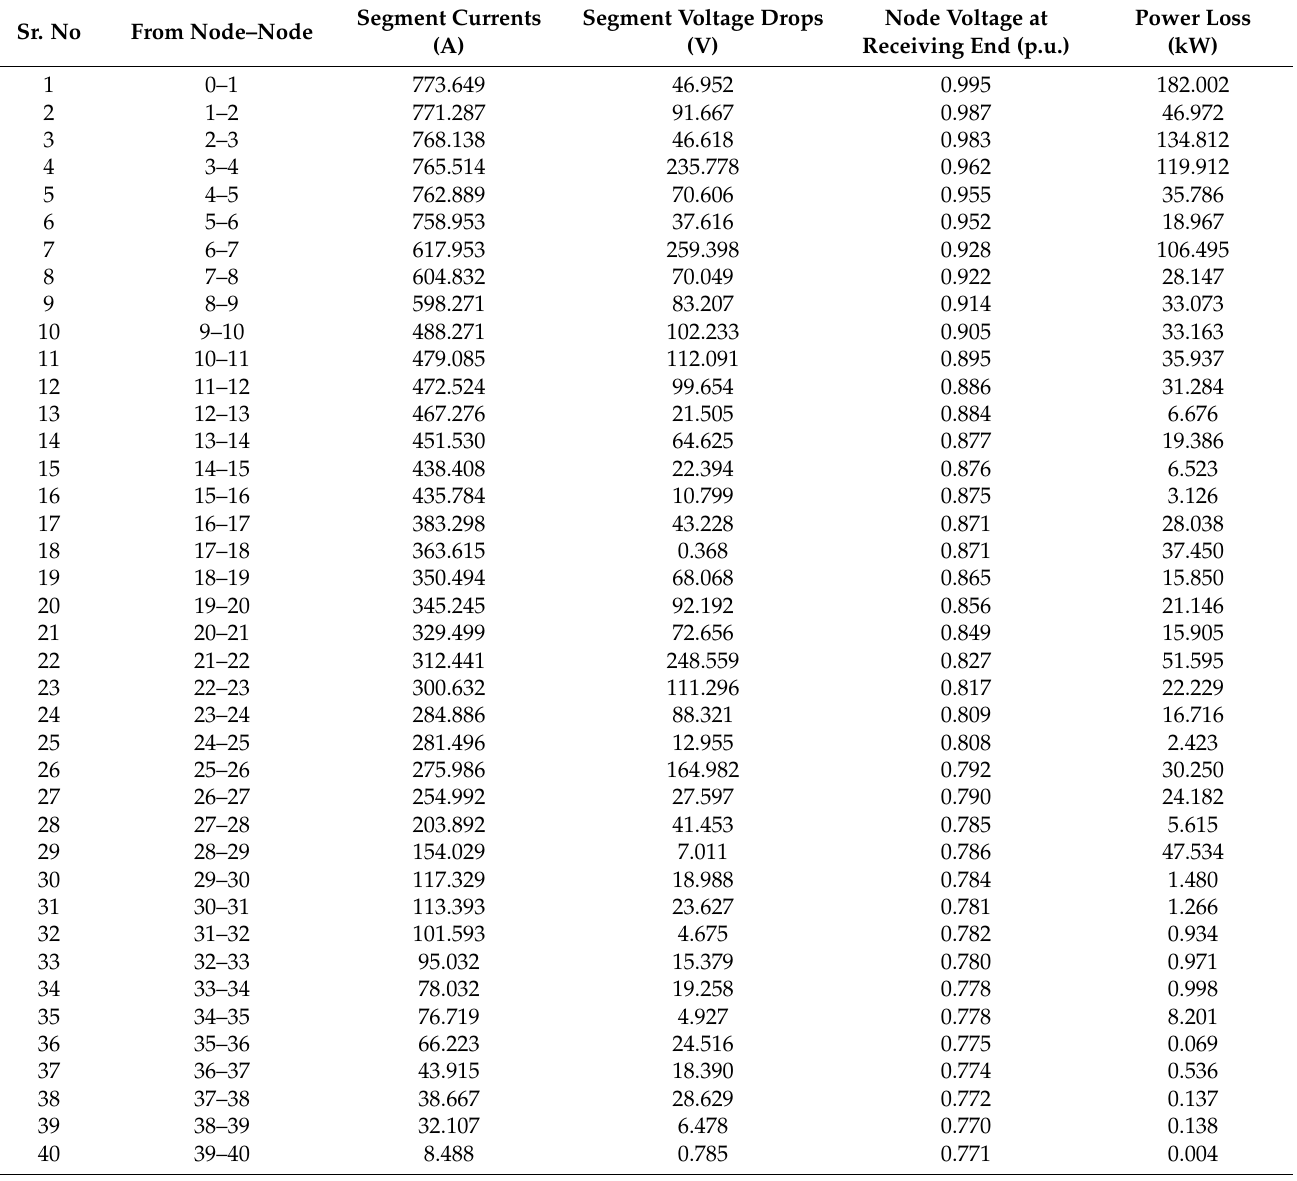
Table 2. Load flow results For DN without